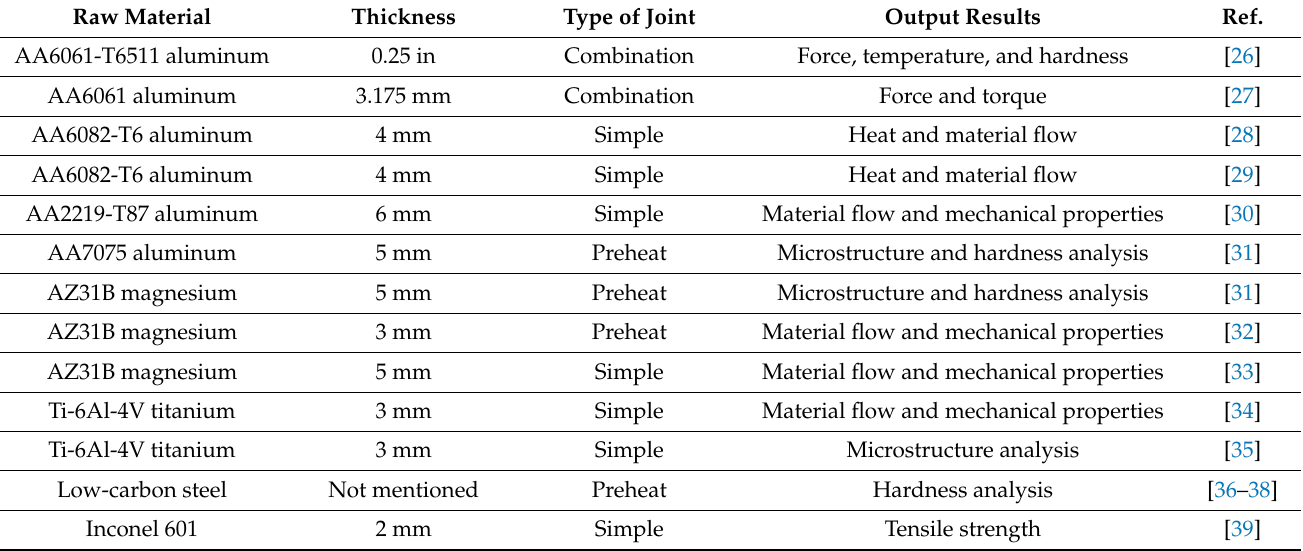
Table 3. Used joint types during EA-FSW of similar